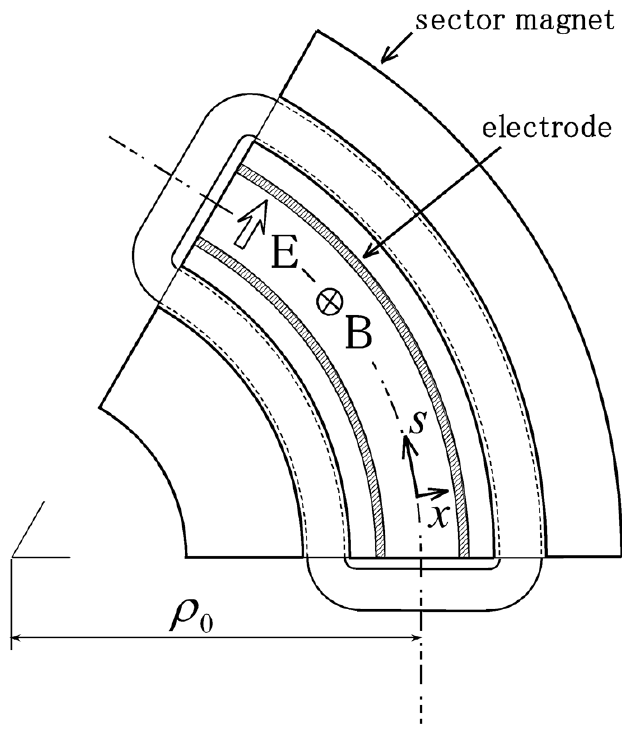
FIG. 2. Example of a dispersion suppressor. A curved electro- static deflector is installed in the gap of a dipole magnet. Note that the direction of the electric field is radially